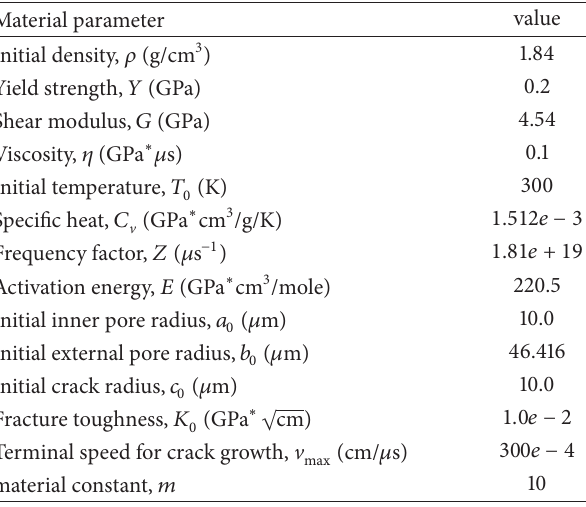
Figure 3: Time evolution of pore radius under three different external pressures with Whitworth model.